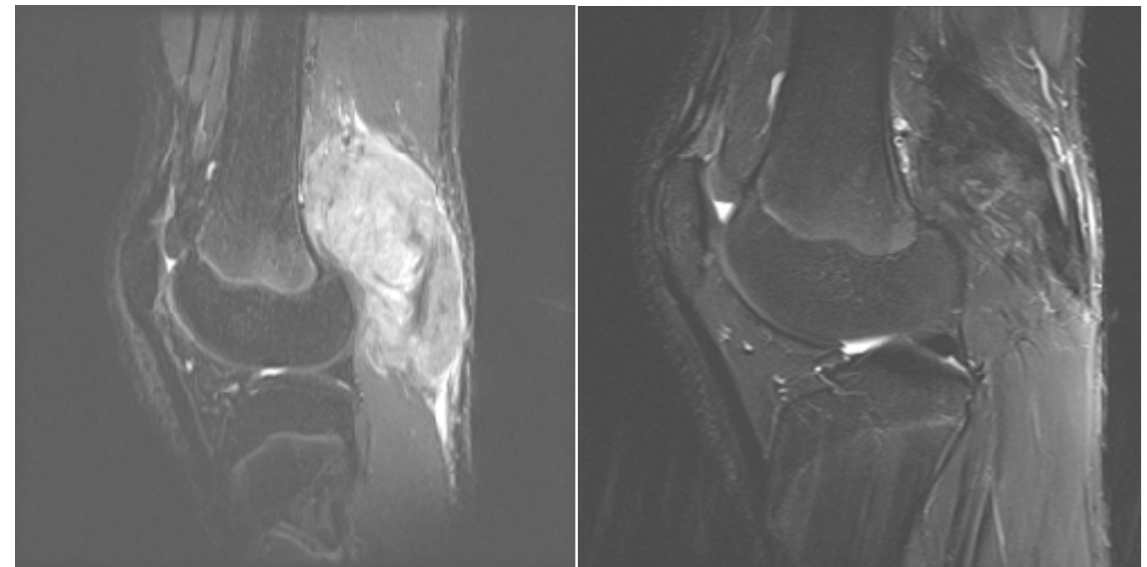
Figure 2. T2 sagittal MRI images before and after treatment demonstrate significant reduction in lesion size after